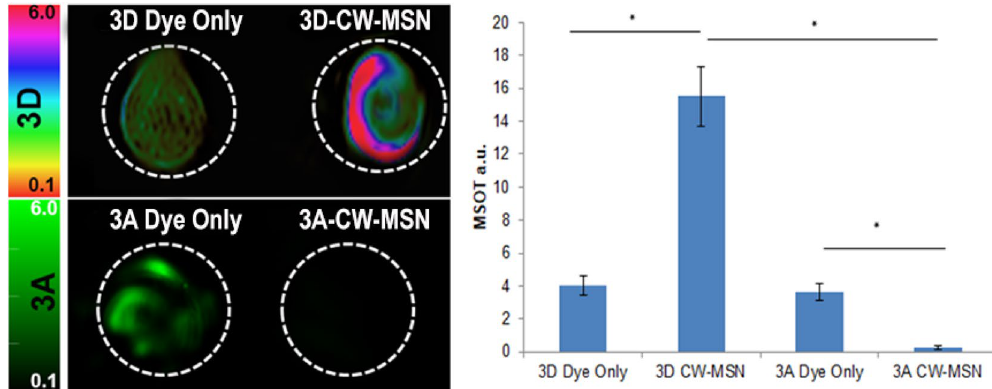
Figure 4. Optoacoustic imaging of tissue mimicking phantoms containing compounds 3D (top) and 3A (bottom) both as free dye (1 mM) (left) and as dye encapsulated in CW-MSN (0.1 OD) (right). Different colorbar scales are used to denote different dyes (HSB_HSL for compound 3D and green for compound 3A ). Dyes 3A and 3D only controls showed similar MSOT signal strengths of 3.6 a.u. and 4.0 a.u., respectively. The optoacoustic signal presented by 3A CW-MSN was significantly lower (0.23 a.u.) than that of 3A dye only. An opposite trend was observed for comparison the optoacoustic signal of 3D dye only control and the signal of 3D CW-MSN, 15.5 a.u., which was significantly higher than both free 3D dye (4.0 a.u. signal) and 3A CW-MSN (0.23 X signal) p < 0.05. The retention of 3D within the CW-MSN is likely due to the hydrophobic nature of the dye in comparison to the more hydrophilic 3A